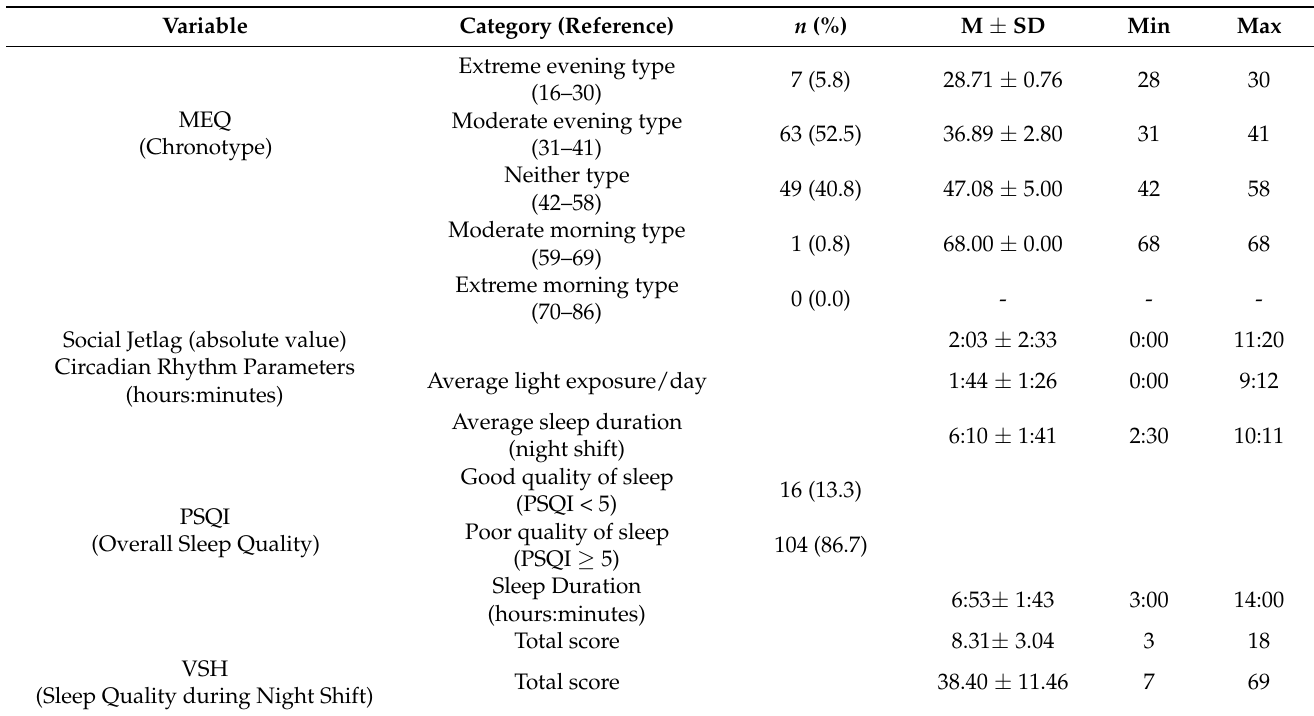
Table 2. Morningness–Eveningness Questionnaire (MEQ) score, Chronotype 5 categories, Circadian rhythm parameters, and quality of sleep of subjects ( n =